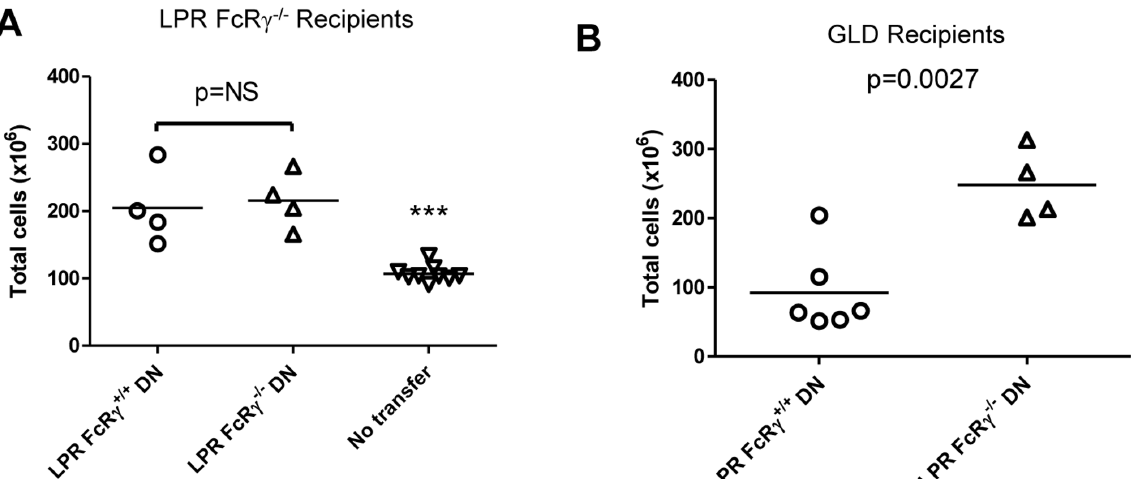
Figure 4. Control of lymphoproliferative disease by LPR DN T cells requires both Fas and FcR c . A. B6.LPR.FcR c 2 / 2 mice aged 4 weeks received two i.v. injections, two weeks apart, each of either B6.LPR.FcR c + / + DN T cells (n=4) or B6.LPR.FcR c 2 / 2 DN T cells (n=4). Cells derived from one-two donor mice (generally 10–20 6 10 6 cells per dose) were used for each injection, ensuring that an equivalent number of B6.LPR.FcR c 2 / 2 and B6.LPR.FcR c + / + DN T cells were transferred on each occasion. After a further 4 weeks, total spleen and lymph node cell counts were determined. Total cell counts for a group of 8 week old uninjected B6.LPR.FcR c 2 / 2 mice (n=9) are shown for comparison. One-way ANOVA p , 0.0001; ***Bonferroni post tests p , 0.001 for the comparison of untreated mice to both groups of treated mice; Bonferroni post test p=NS for the comparison of the two groups of treated animals. B. B6.GLD mice aged 6 weeks were given either B6.LPR.FcR c + / + or B6.LPR.FcR c 2 / 2 DN T cells. Cells derived from one-two donor mice were used for each injection (between 10–20 6 10 6 cells), ensuring that an equivalent number of B6.LPR.FcR c 2 / 2 and B6.LPR.FcR c + / + DN T cells were transferred. After 3 weeks, total splenocyte counts were determined. Unpaired t test, p=0.0027.